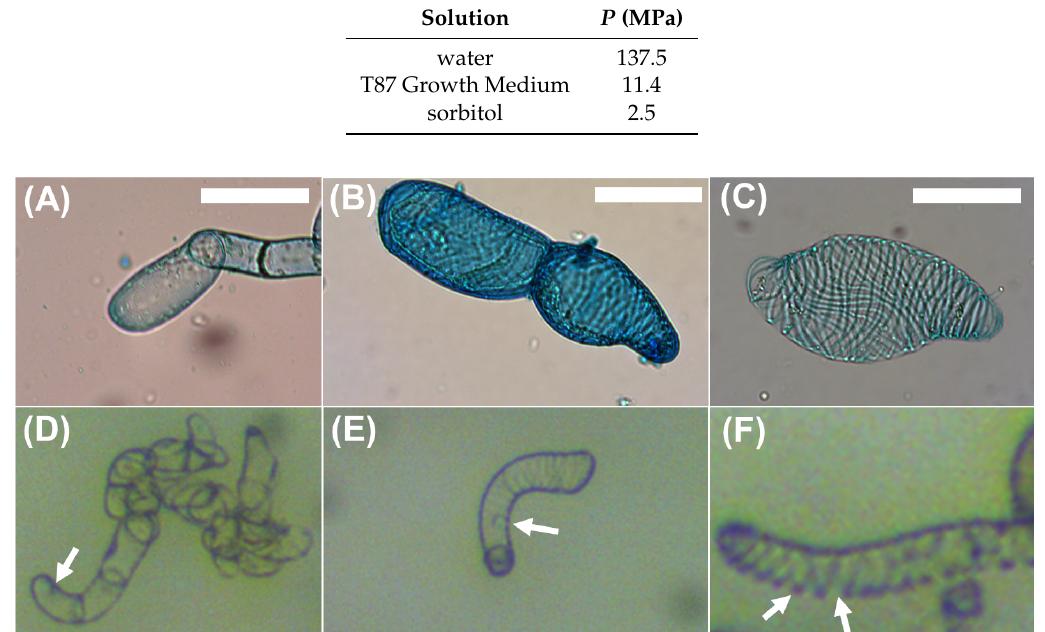
Figure A1. ( A – C ) Optical microscopy images and ( D – F ) images from the micro-mechanical testing device to demonstrate cell classification process. ( A , D ) Living cells in stage 1 of transdifferentiation (only PCW observed, arrow points to cell nucleus). ( B , E ) Living cells in stage 2 of transdifferentiation (PCW and SCW are both present, cytoplasm is still inside the cell, arrow points to cell nucleus); ( C , F ) Living cells in stage 3 of transdifferentiation (SCW and partially perforated PCW, cytoplasmic contents almost entirely removed, arrow points to locations where PCW is degraded). All scale bars are 20 µ m.